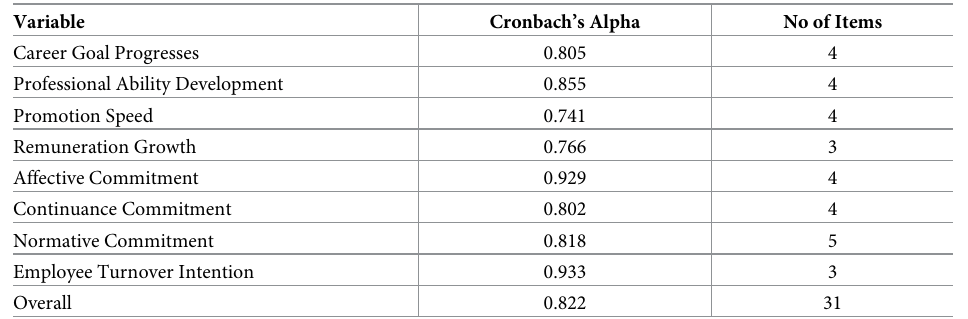
Table 4. Reliability statistics of